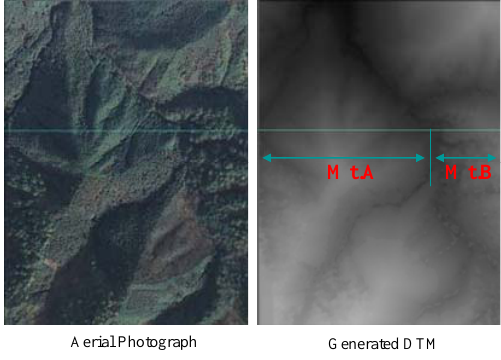
Figure 4. Result of DTM